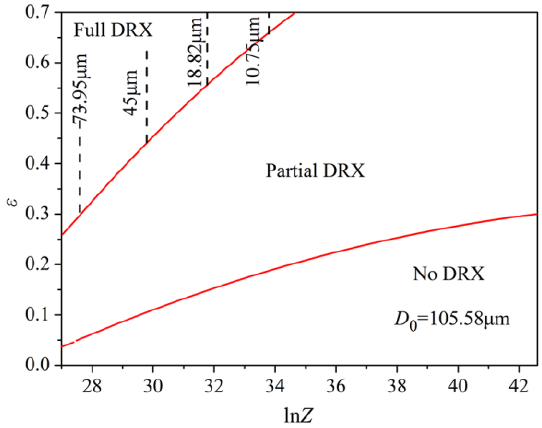
Figure 10. DRX map of the experimental steel.